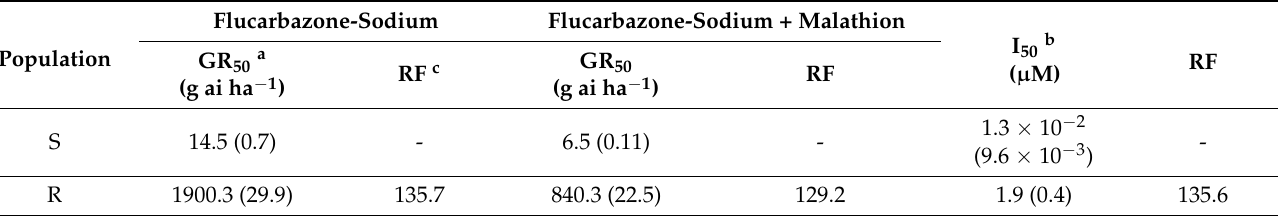
Table 1. GR 50 and I 50 values of B. japonicus populations treated with flucarbazone-sodium.